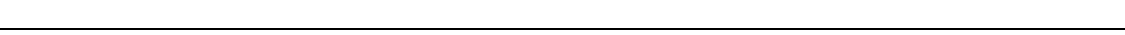
Fig. 1 LSP1 is a component of the podosome cap structure. a – d Confocal micrographs of a macrophage stained for LSP1 using speci fi c primary antibody and Alexa 488-labeled secondary antibody ( a , green), for F-actin using Alexa405-labeled phalloidin ( b , red), and for vinculin using speci fi c primary antibody and Alexa568-labeled secondary antibody ( c , white), with merge ( d ). White boxes in a – d indicate detail images shown as insets. Dashed boxes in insets indicate single podosome shown in x – z section in a ′ – d ′ and in x – y section in a ″ – d ″ with respective cross-section planes shown as white dotted lines. Dashed yellow lines in d ′ indicate confocal planes used for measurements of respective fl uorescence intensities shown in e . Note the cap-like localization of LSP1 on top of the F-actin core (1), which can appear ring-like in a lower optical section (2) Scale bars: 5 µ m in a – d , 1 µ m in insets, 0.5 µ m in a ″ – d ″ . f 3D reconstruction of two podosomes from STED micrographs macrophages stained for LSP1 (green) and F-actin (red), scale unit: 0.25 µ m. See also Supplementary Movie 1. g Domain structure of LSP1 full length and deletion mutants. LSP1 features an acidic N-terminal half containing a hypothetical Ca 2+ binding domain, two caldesmon-like F-actin binding domains (C1, C2) and two villin-headpiece-like F-actin binding domains (V1, V2). First and last amino acid residues are indicated. “ + ” and “ − ” indicate the presence or absence of the respective construct at